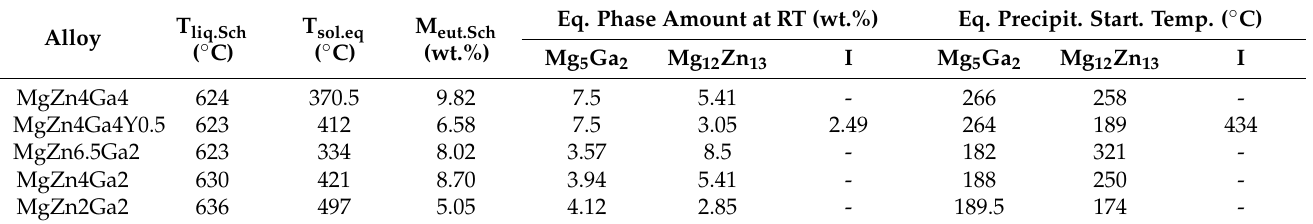
Table 2. The Mg − Zn − Ga alloys phase composition and phase transition temperatures calculated via FactSage software.